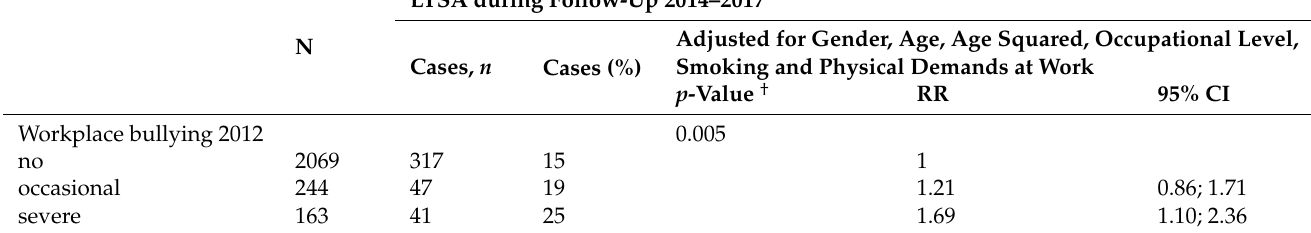
Table 3. Associations between baseline workplace bullying in 2012 and 405 cases of long term sickness absence (LTSA) 2014–2017 * among 2476 employees aged 31 to 60 years in Germany in 2012. Multiple binomial regressions. Rate Ratios